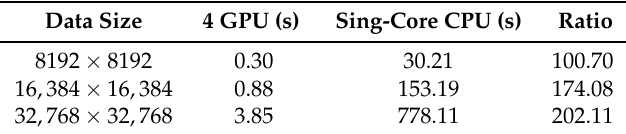
Table 3. Running time of multi-GPU based method.